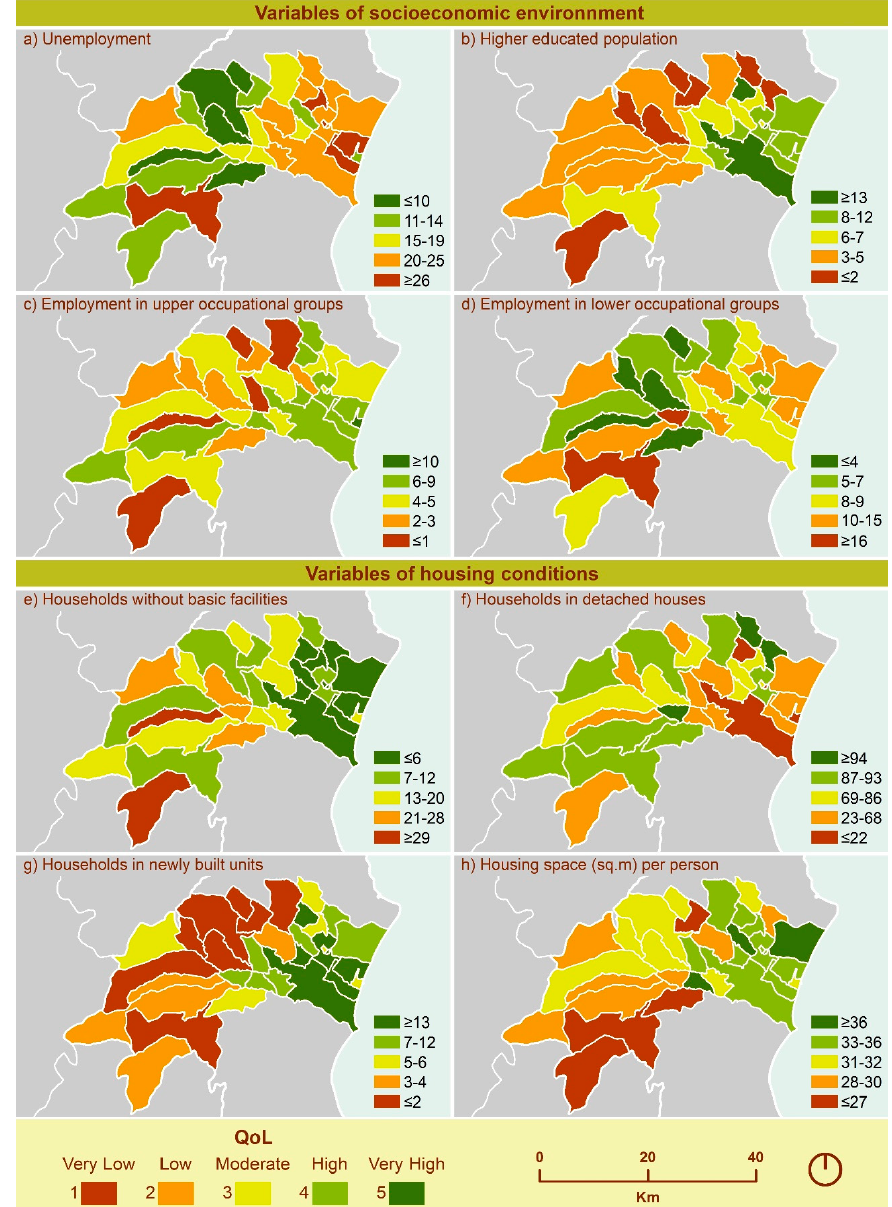
Figure 4. Variables of socioeconomic environment and housing conditions (%), LAUs of the Katerini Municipality. ( a ) percentage of unemployment, ( b ) percentage of higher educated population, ( c ) percentage of employment in upper occupational groups, ( d ) percentage of employment in lower occupational groups, ( e ) percentage of households without basic facilities, ( f ) percentage of households in detached houses, ( g ) percentage of households in newly built units, ( h ) housing space per person in m 2 .